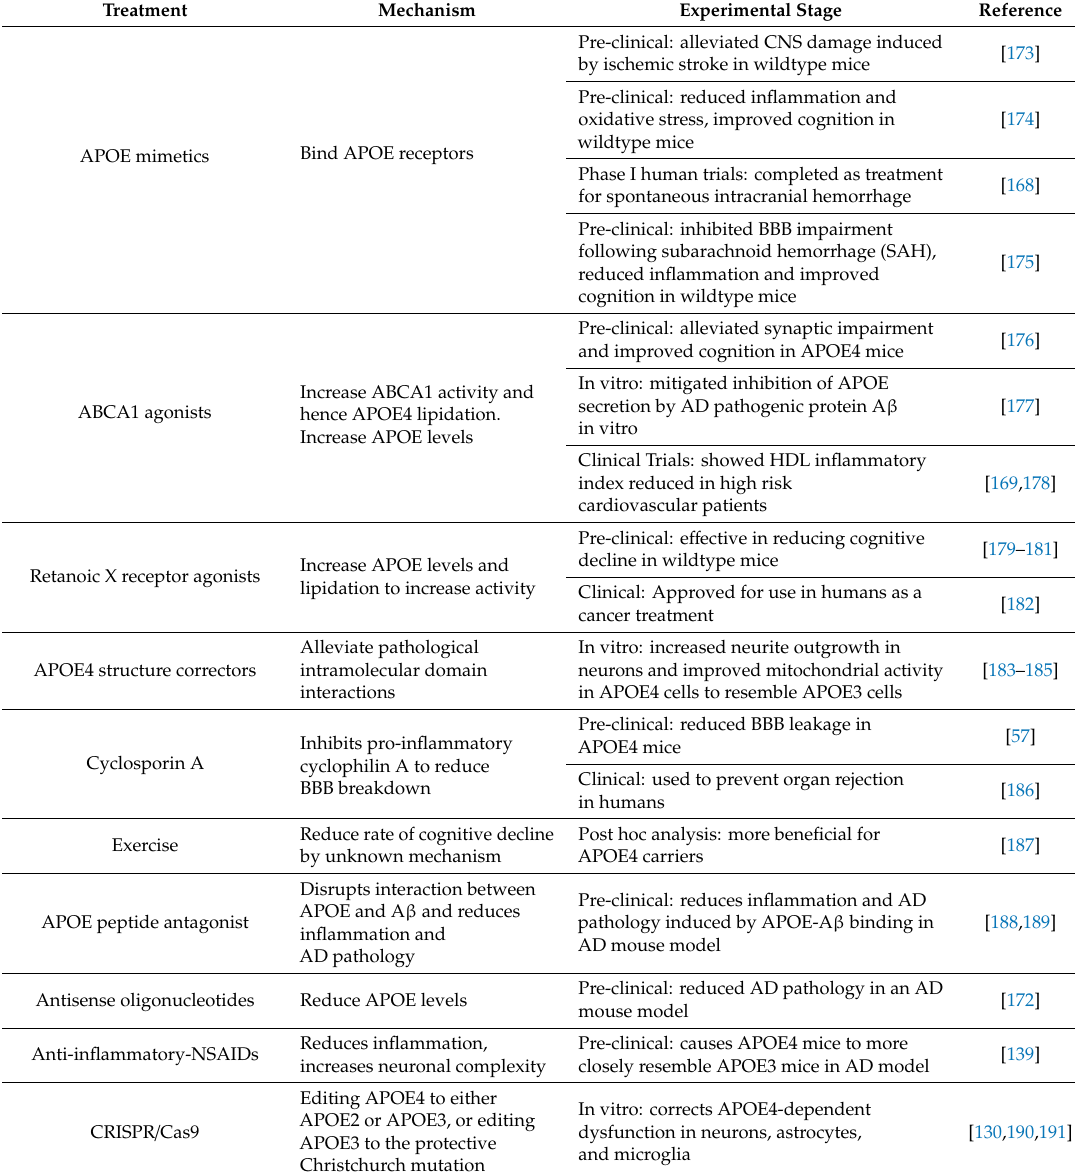
Table 2. Potential interventions to reduce the severity of cancer related cognitive